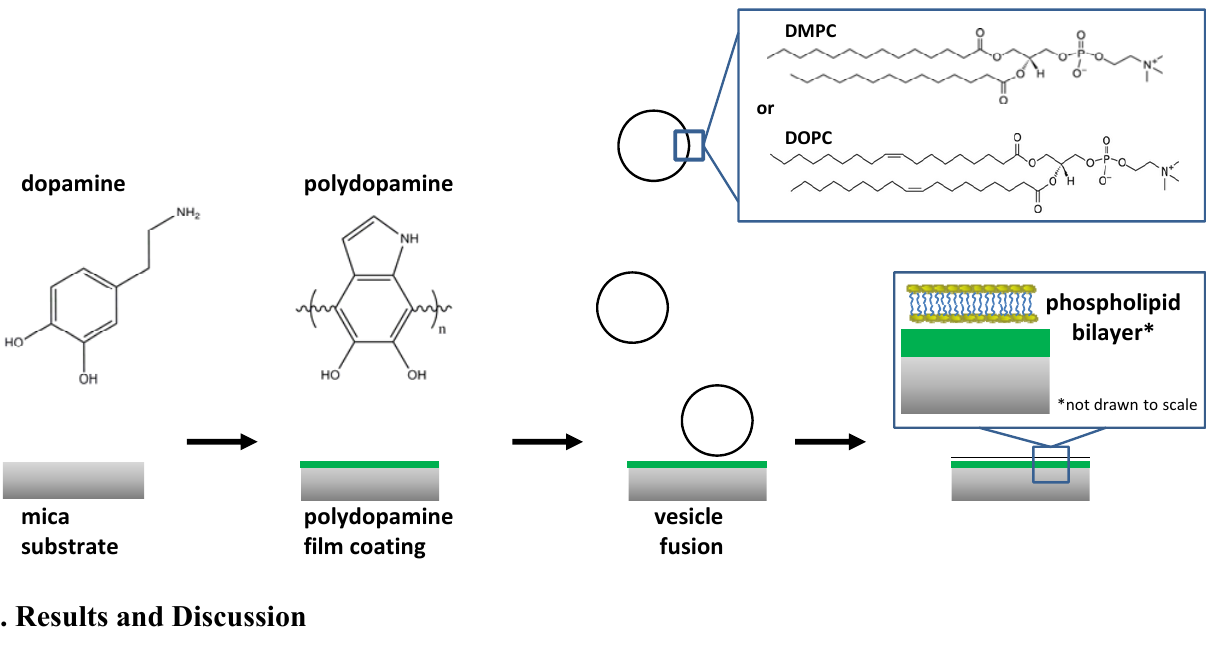
Figure 1. Preparation of polydopamine-supported membranes and the structure of polydopamine as suggested by Lee et al.